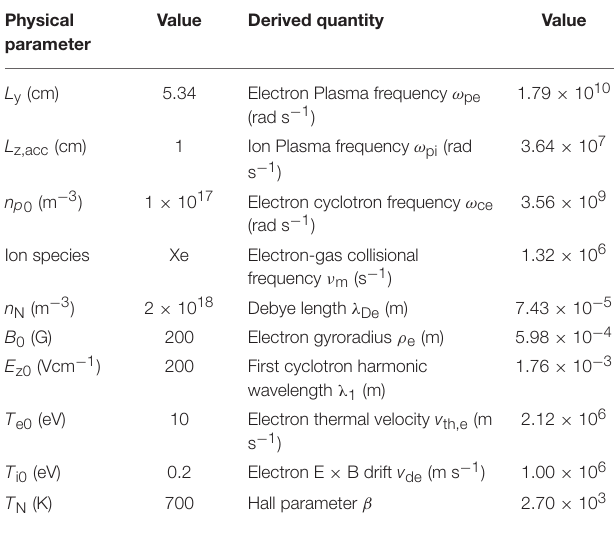
TABLE 1 | Physical parameter used in the test